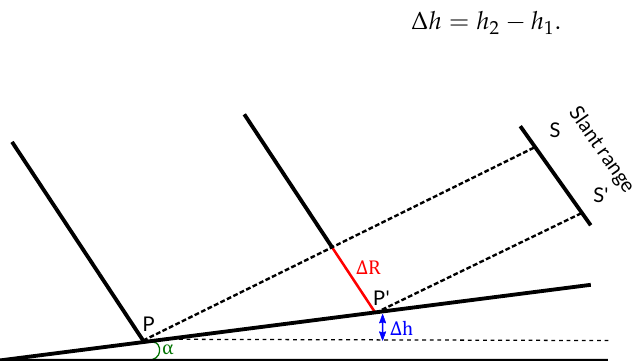
Figure 4. Local terrain slope ( α ) acquisition geometry between two adjacent points ( S and S (cid:48) ). From trigonometry, we obtain the local slope between two adjacent pixels as